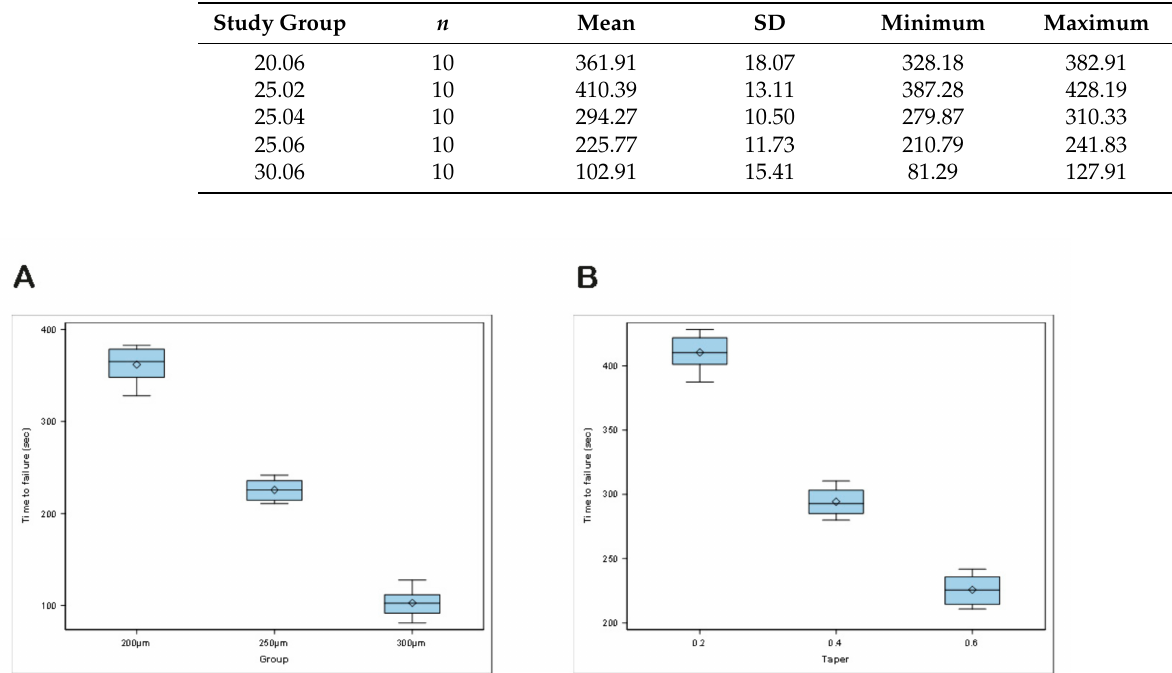
Figure 5. Box plots of the time to failure for the ( A ) apical diameter and ( B ) taper study groups. The horizontal line in each box represents the respective median